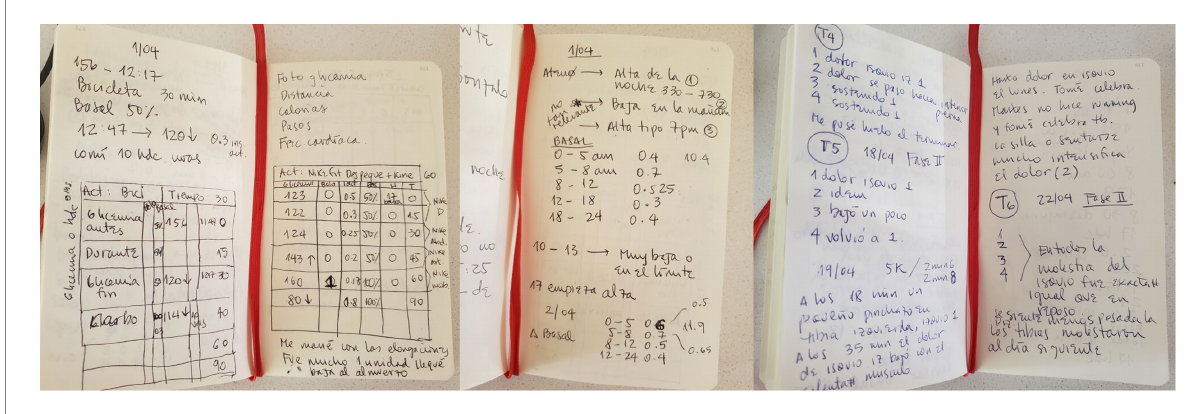
FIGURE 3 Autoethnographic diary pages showing representative notes of PA